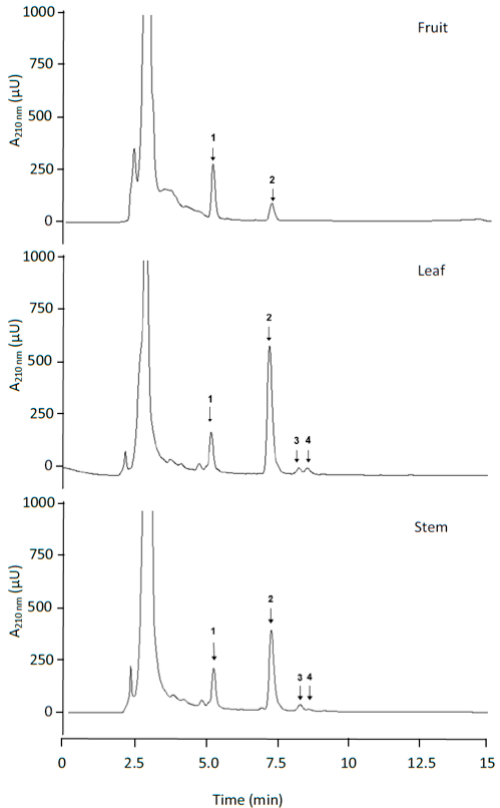
Figure 3. Chromatograms obtained after reverse phase HPLC-UV / Vis analysis of fruit, leaf and stem olive tree triterpenic extracts. Compound 1—maslinic acid, 2—oleanolic acid, 3—erythrodiol,